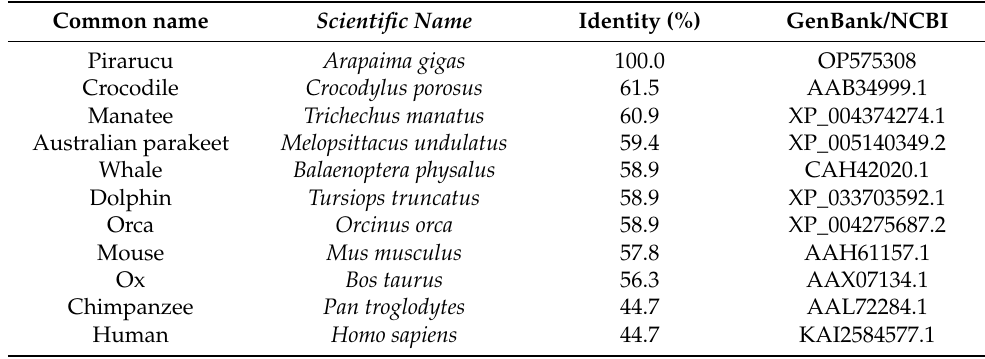
Table 4. Percentage identity of GH peptides of different species relative to A.